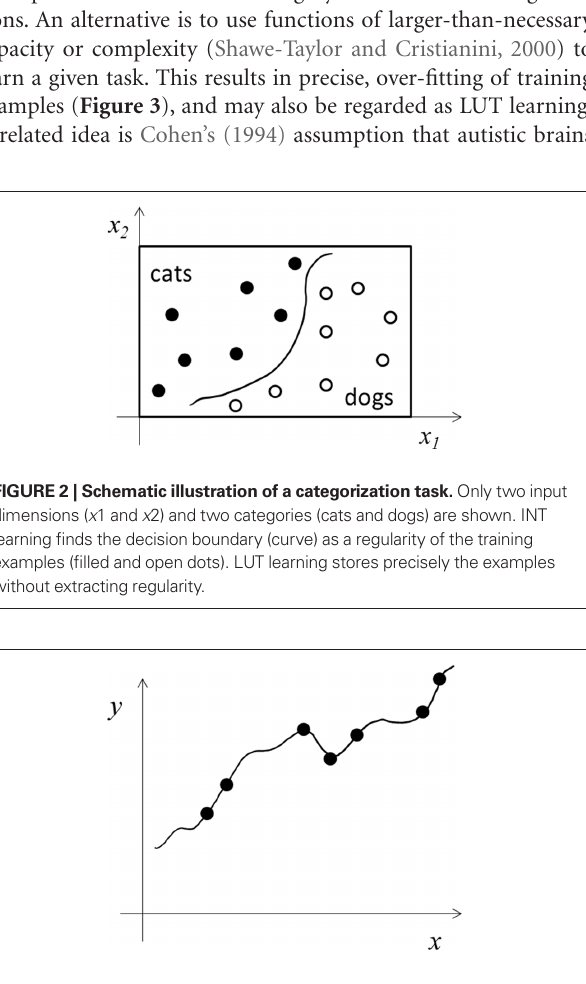
Figure 3 | Schematic illustration of over-fitting using functions of larger-than-necessary capacity. This version of LUT learning cannot explain autism (see text) and will not be considered further in